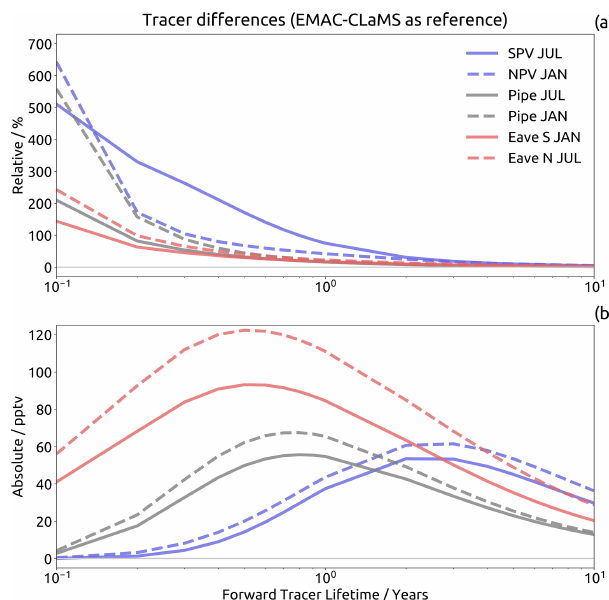
Figure 3. Inter-representation difference ( a relative difference, EMAC-FFSL minus EMAC-CLaMS normalized by EMAC- CLaMS; b : absolute difference, EMAC-FFSL minus EMAC- CLaMS) in forward tracer mixing ratios in several regions during January (“JAN”) and July (“JUL”), versus exponential decay life- time of the tracer. Results are shown for the southern polar vor- tex (“SPV”, 70–90 ◦ S, 450K), northern polar vortex (“NPV”, 70– 90 ◦ S, 480K), tropical pipe (“Pipe”, 5 ◦ S–5 ◦ N, 500K), and sum- mertime eave locations (“Eave”, 50 ◦ –75 ◦ north or south,